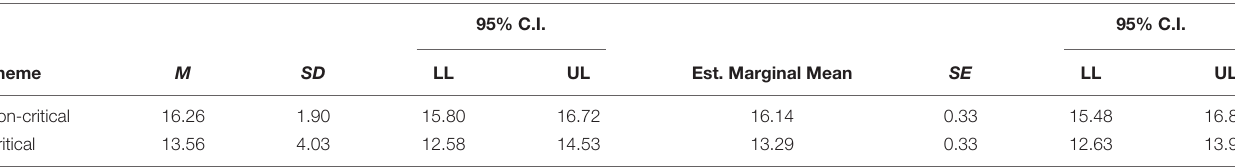
Means and SD were computed without adjusting for the covariates and for the factor “Veracity.” Estimated marginal means show the mean effect for the factor Theme, adjusting for the effect of the covariates and factor Veracity. TABLE 3 | Means, standard deviations, and 95% confidence intervals for the factor “Veracity” obtained from the linear mixed model used for hypothesis testing. 95% C.I. 95%